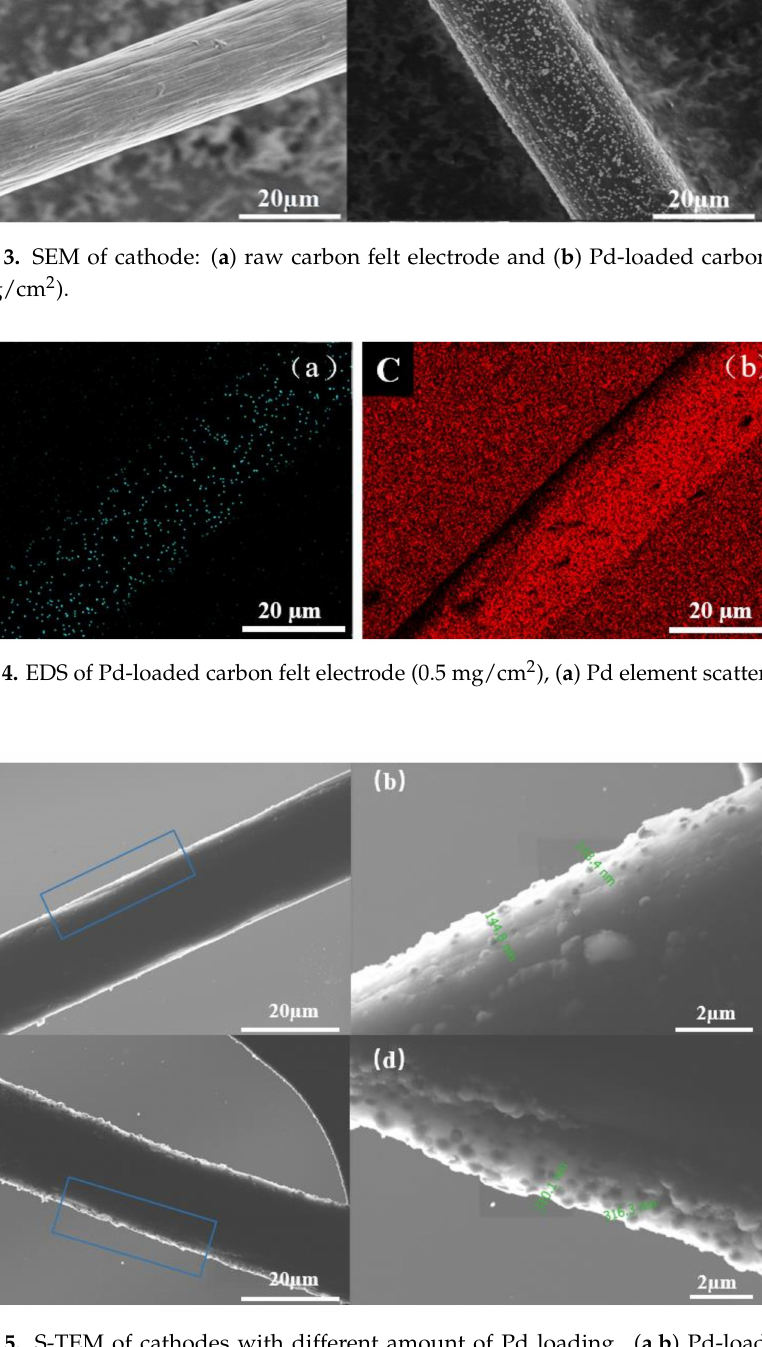
Figure 5. S-TEM of cathodes with different amount of Pd loading. ( a , b ) Pd-loaded carbon felt electrode (0.25 mg/cm 2 ); ( c , d ) Pd-loaded carbon felt electrode (0.5 mg/cm 2